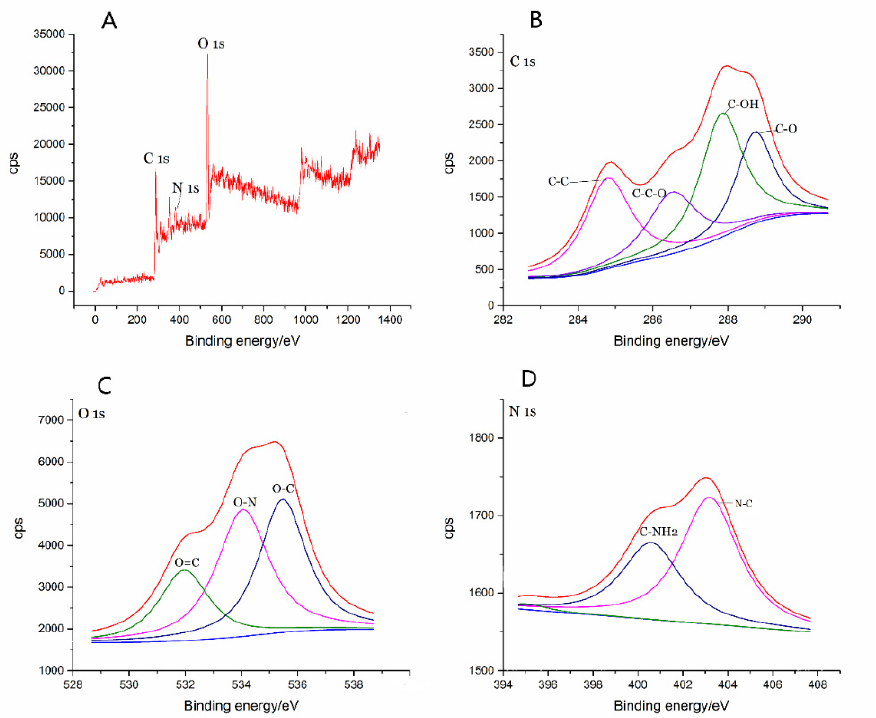
Figure 3. ( A ) X-ray photoelectron spectroscopy (XPS) survey spectra. ( B ) C 1s, ( C ) O 1s and ( D ) N 1s XPS spectra.